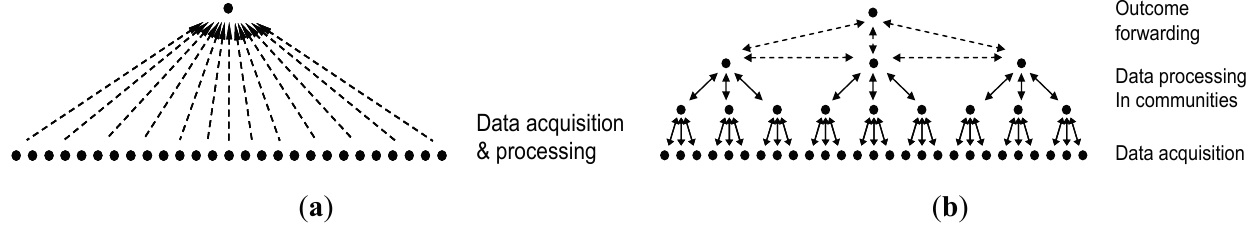
Figure 1. Data acquisition and processing schemes [7]. ( a ) Decentralized independent processing; ( b ) Decentralized coordinated